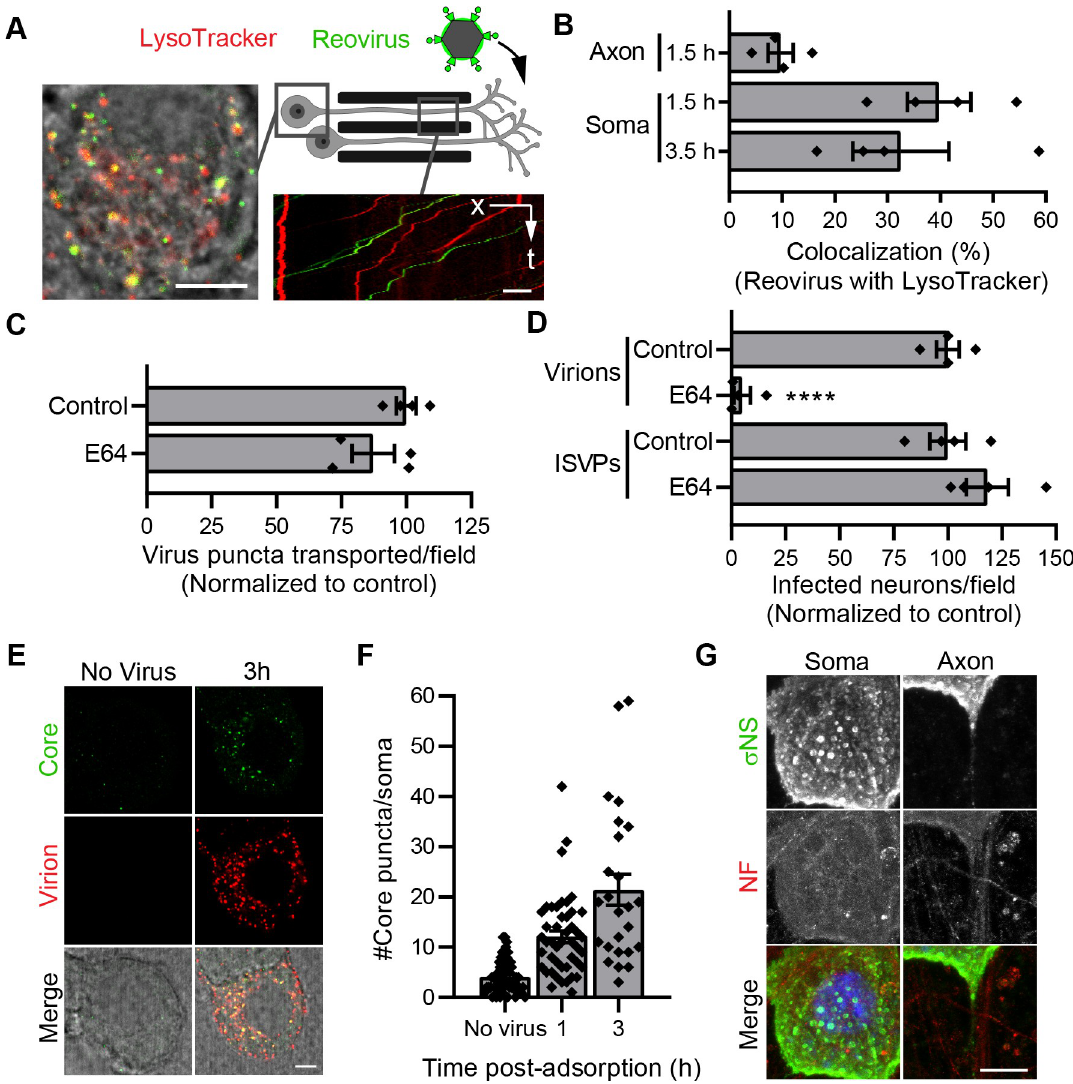
Fig 7. Disassembly of reovirus occurs in neuronal soma following axonal transport. (A-B) DRGNs cultivated in microfluidic devices were adsorbed in the axonal compartment with fluorescently-labeled T3SA+ virions (green) for 1 h. LysoTracker (red) was added to both compartments during the last 20 min of virus adsorption, and cells were imaged at the times shown after virion addition. Representative images show LysoTracker and reovirus distribution in a DRG soma (A—left, micrograph) and motion in axons within a microgroove (A—right, kymograph). Scale bars, 5 μ m. The percentage of reovirus puncta co-transported with LysoTracker in axons within the microgrooves or colocalized with LysoTracker in the soma were quantified (B). Bars indicate means from at least two independent experiments with a total of four devices. Error bars indicate SEM. Individual data points are averages from at least 16 microgrooves containing axons or 8 to 12 fields-of-view containing soma from each device. (C) CNs were treated with E64 (Table 1), and T3SA+ puncta transported per field-of-view were enumerated following treatment. (D) CNs were treated with E64, adsorbed with T3SA+ virions or ISVPs at an MOI of 50,000 particles/cell, and infectivity was quantified at 24 h post-adsorption. In C and D, bars indicate means normalized to untreated controls. Error bars indicate SEM. Data are representative of two independent experiments, each with duplicate samples. Individual data points are averages from 8 to 12 fields-of-view from each sample. Values that differ significantly from control by t -test are indicated ( ���� , P < 0.0001). (E-F) DRGNs were adsorbed with fluorescently-labeled T3SA+ virions (red) for 30 min and incubated at 37˚C for 1–3 h before fixation and staining with anti-core polyclonal serum (green). Representative fluorescence micrographs (E) and quantification of the number of reovirus core puncta per soma (F) are shown. Scale bar, 5 μ m. Bars indicate means from two samples each with > 23 soma. Error bars indicate SEM. (G) Representative micrographs show distribution of T3SA+ replication factories stained by σ NS antiserum and axons stained by an antibody against non-phosphorylated neurofilament H (NF). Scale bar, 10 μ m.